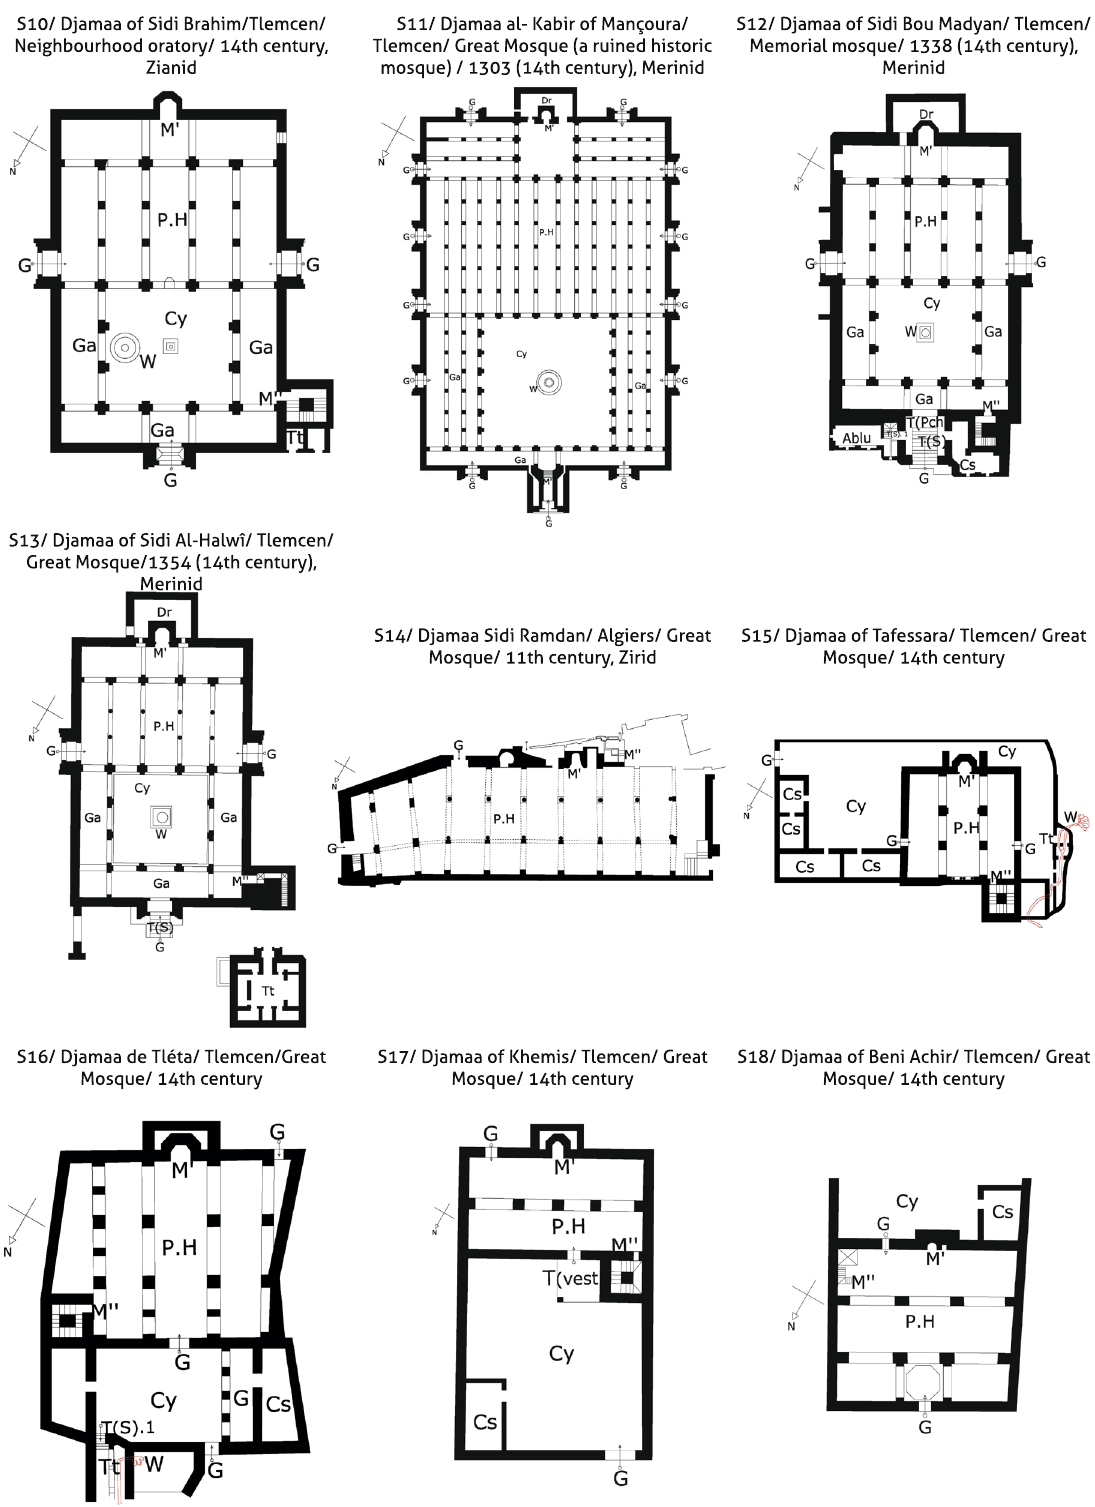
Fig. 4 Corpus study (S10–S18): Mosque/ Location/ Type/ Period construction/ Plan (Source: the